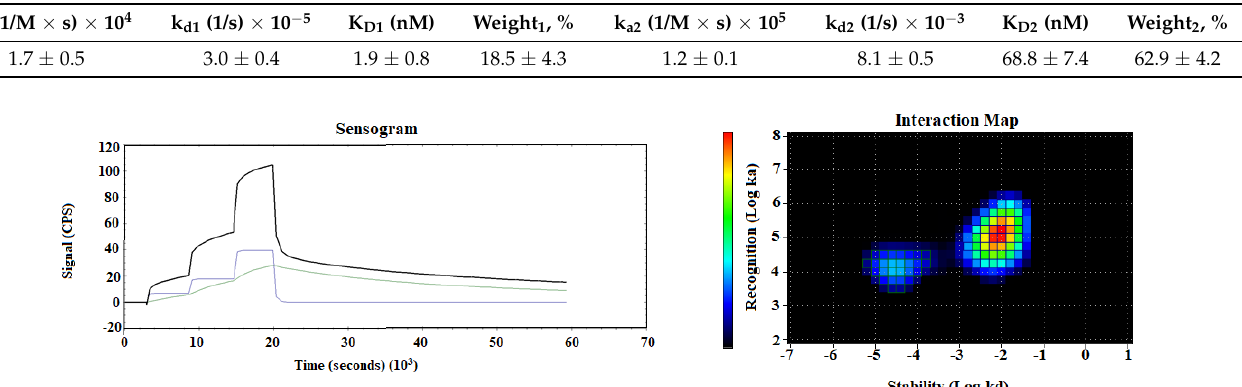
. Figure 8. Uptake of [ 99m Tc]Tc-AC12-GGGC in SKOV-3 (B7-H3-positive) and Ramos (B7-H3-nega- tive) xenografts at 4 h after injection. Data are expressed as %ID/g and are averages from four mice ± SD. p -value was obtained in unpaired t -test. Biodistribution data and tumour-to-organ ratio of [ 99m Tc]Tc-AC12-GGGC at 2 and 4 h after injection are presented in Table 2. [ 99m Tc]Tc-AC12-GGGC showed that the tumour uptake amounted to 2.1 ± 0.5 %ID/g already at 2 h after injection. The clearance of activity from the tumour and other tissues over time was in line with the non-residualizing prop- erties of the label. The tumour uptake decreased by a factor of two by 4 h after injection (1.0 ± 0.1 %ID/g). Moreover, the clearance from blood and normal organs and tissues such as salivary glands, lung, pancreas, stomach, muscle and bone was very rapid over time. No significant difference in renal-associated activity was observed for both time points (13.7 ± 1.8 %ID/g for 2 h p.i. compared to 10.3 ± 1.1 %ID/g for 4 h p.i.). Such a biodistribu- tion pattern resulted in significantly ( p < 0.05) higher tumour-to-blood at 4 h (11.0 ± 0.5) compared to 2 h (8.2 ± 1.9) after injection (Table 2). Importantly, significantly ( p < 0.05) higher tumour-to-liver (0.7 ± 0.1 for 2 h p.i. in comparison to 0.4 ± 0.1 for 4 h p.i.) and